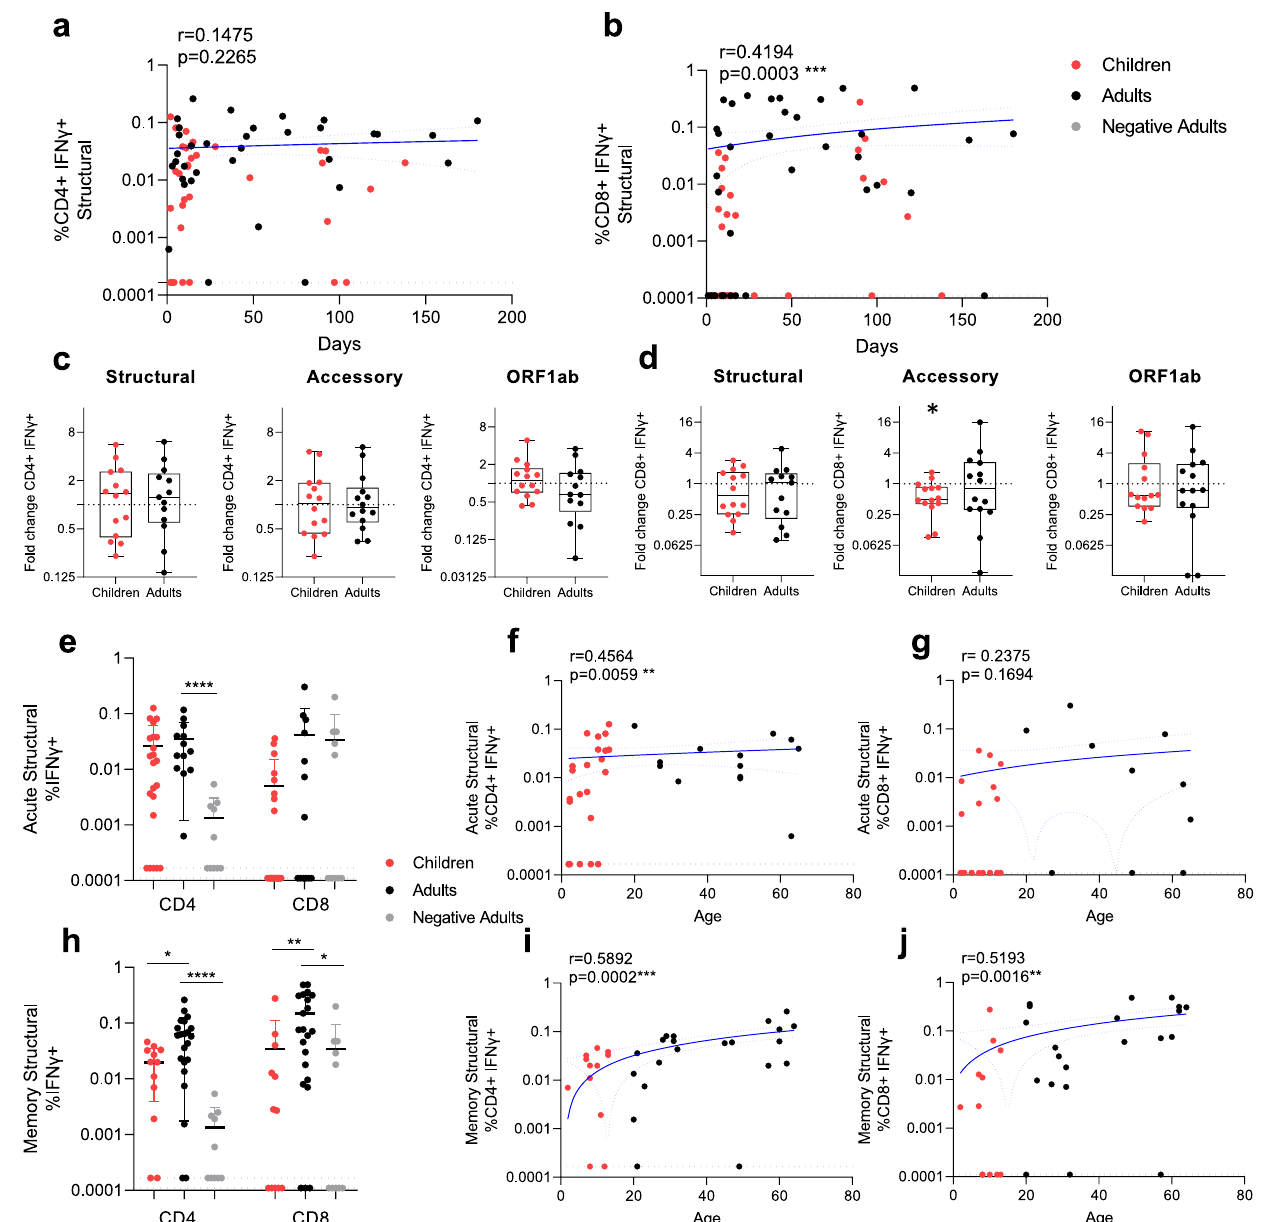
Fig. 5 SARS-CoV-2 speci fi c T cell responses increase over time and age. Correlation of IFN γ responses for CD4 + ( a ) and CD8 + ( b ) T cells against the structural peptide pool with children (red) ( n = 34) and adults (black) ( n = 36) (with background IFN γ production to DMSO subtracted), against days post symptom onset. Black dotted lines represent the limit of detection (IFN γ of CD4 + = 0.000167 ( a ), IFN γ of CD8 + = 0.00011( b )). Fold change of IFN γ CD4 + ( c ) and CD8 + ( d ) T cell responses were calculated as the later time point (mean±stdev: 32.8±35.7 days, range: 9 – 138) over admission time point responses (mean±stdev: 7.6±4.2, range: 2 – 15)) in response to the structural, accessory and ORF1ab peptide pools in children and adults from two independent experiments (children n = 14, adults n = 14). Data is representative of individual data points with boxes and whiskers graphs showing the median, upper and lower quartiles, minimum and maximum. One-sample Wilcoxon tests were used for determining signi fi cance of fold changes, where * p <0.05. Acute (samples < 14 days post symptom onset, mean±stdev: 8.0±3.8, range: 1 – 14, n = 22 children, n = 14 adults) ( e – g ), and convalescent/memory ( h – j ) (mean±stdev: 70.5± 41.9, range: 15 – 180 days post symptom onset, n = 12 children, n = 22 adults) IFN γ structural speci fi c ( f , i ) CD4 + and ( g , j ) CD8 + T cell responses and negative controls (n = 10). Data in e and h show individual data points with mean±SD. For statistical comparisons between children and adults, or adults and negatives, two-tailed Mann – Whitney tests were performed, * p <0.05, ** p <0.01, *** p <0.001, **** p <0.0001. The magnitude of the acute (from e) and memory (from h) structural IFN γ CD4 + ( f , i ) and CD8 + ( g , j ) T cell response with age. ( a , b , f , g , i , and j ) r and p values are calculated using two-tailed Spearman ’ s correlation and * p <0.05, **p<0.01, ***p<0.001, ****p<0.0001. Blue lines of linear regression represent the overall trend, and blue dotted lines show the upper and lower 95% con fi dence intervals. All data points are individual responses minus paired background IFN γ response to a DMSO control. ( d ) * p = 0.0245, ( e ) **** p <0.0001, ( h ) * p = 0.0162, 0.0219, ** p = 0.0074, **** p